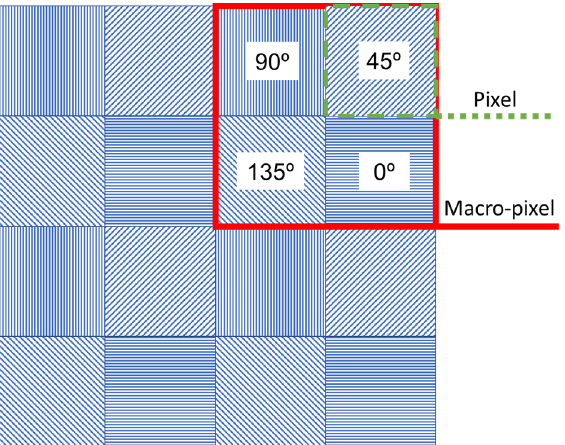
Figure 4. Scheme of the sensor of the polarimetric camera used as a detector. In front of each pixel, the corresponding polarizer is placed. The macro-pixel is the calculation unit.